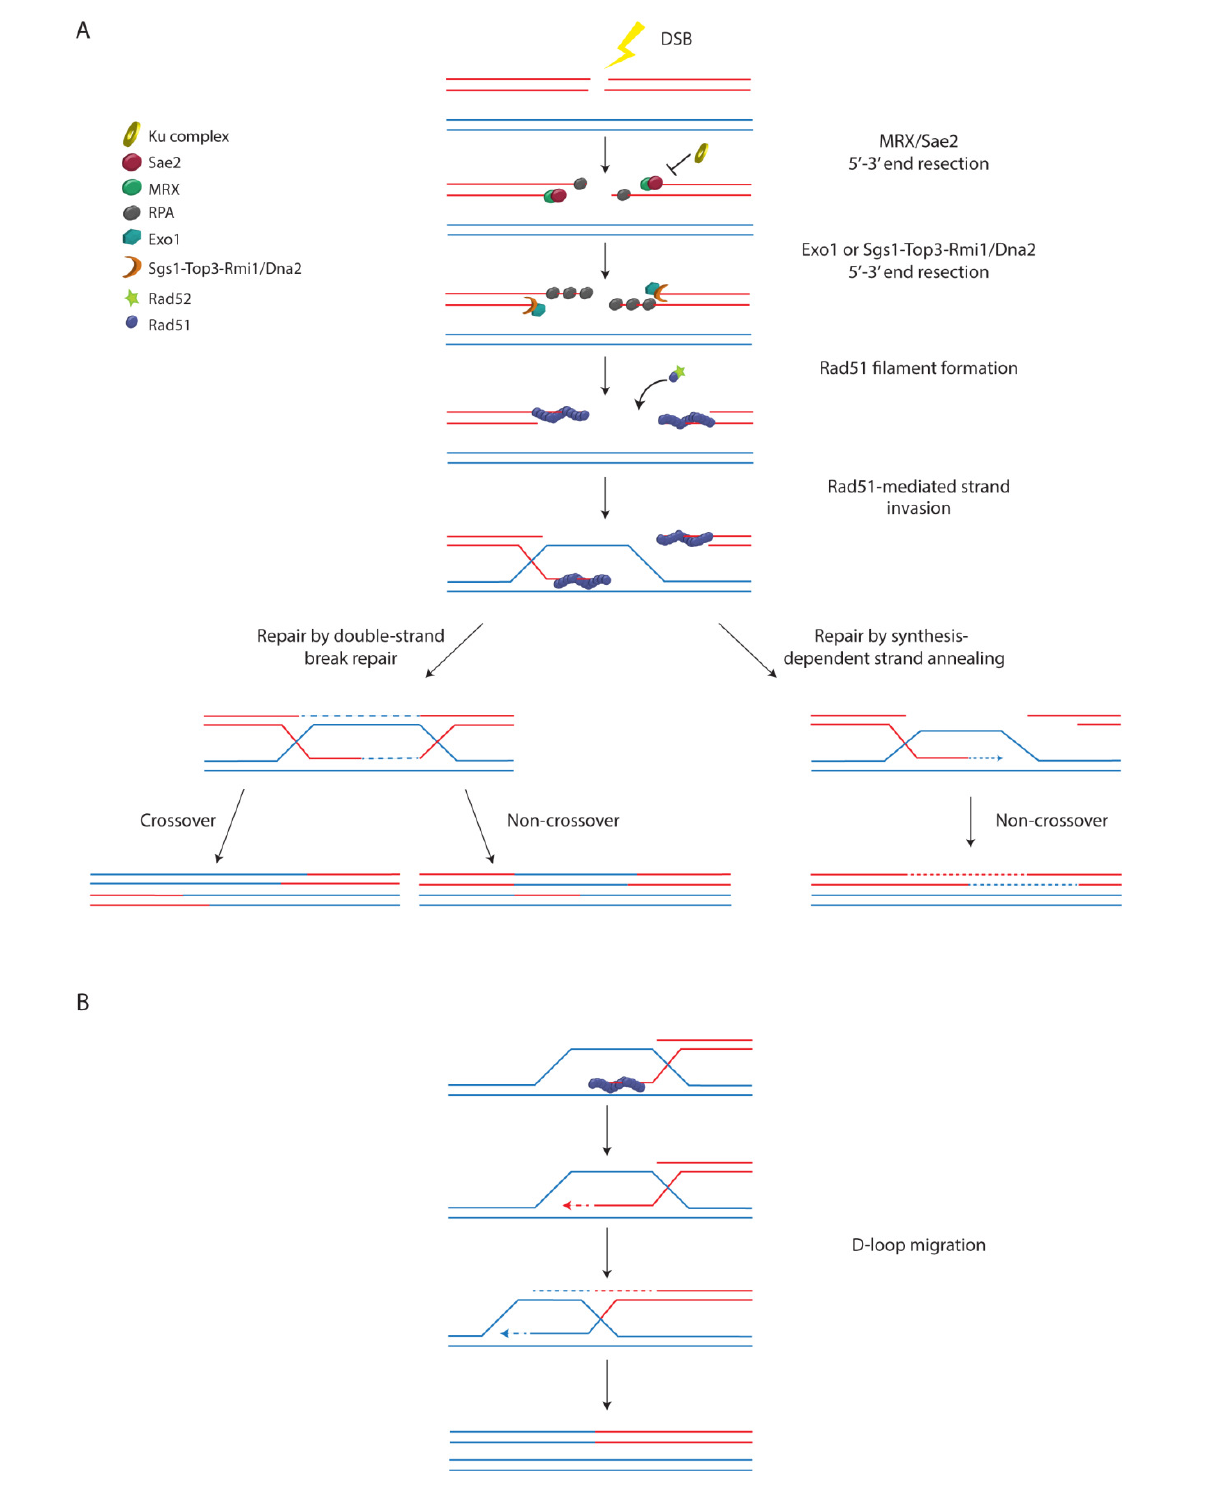
FIGURE 1: Models for homology-dependent DSB repair. (A) HR-mediated repair of a DSB is initiated by 5 ¢ to 3 ¢ resection of the DNA ends by the MRX complex and Sae2, and this resection is inhibited by the Ku complex. More extensive resection is then carried out by either Exo1 or the combined activities of the Sgs1-Top3-Rmi1 complex and Dna2. The resulting single-stranded DNA recruits the ssDNA-binding protein RPA. Rad52 mediates the loading of Rad51 onto RPA-coated ssDNA to form Rad51 nucleoprotein filaments capable of performing strand invasion. Repair can then proceed via the classical double-strand break repair model or the synthesis-dependent strand annealing model. (B) One-ended breaks can be repaired by BIR, which can be Rad51-dependent (as shown here) or Rad51-independent. In BIR, strand invasion leads to the formation of a D-loop that migrates along the chromosome as the invading 3 ¢ overhang is extended. The complementary strand is synthesized by conservative replication. For simplicity, not all proteins involved in DSB repair are